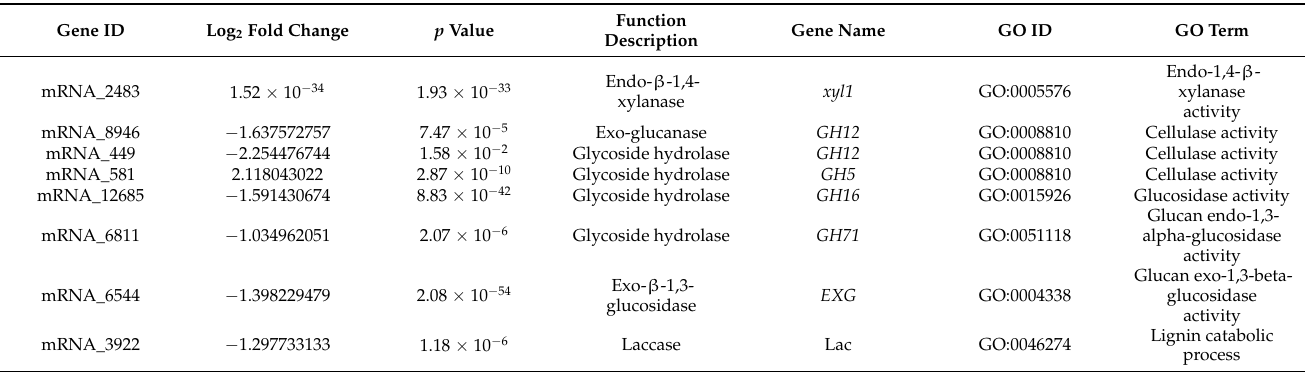
Table 2. Down-regulated DEGs enriched in wood-degrading enzymes in the presence of high oxalic acid concentration.